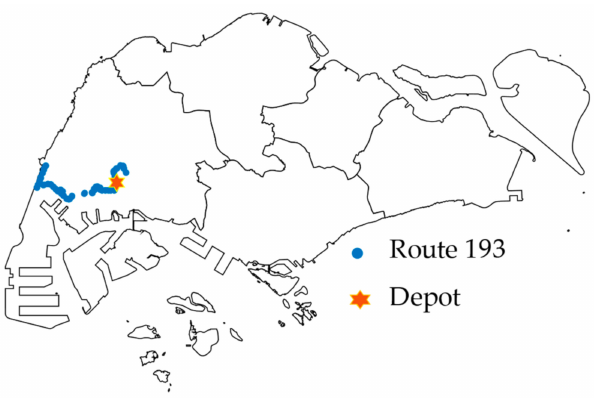
Figure 8. Route analyzed in this case study and the location of the depot.